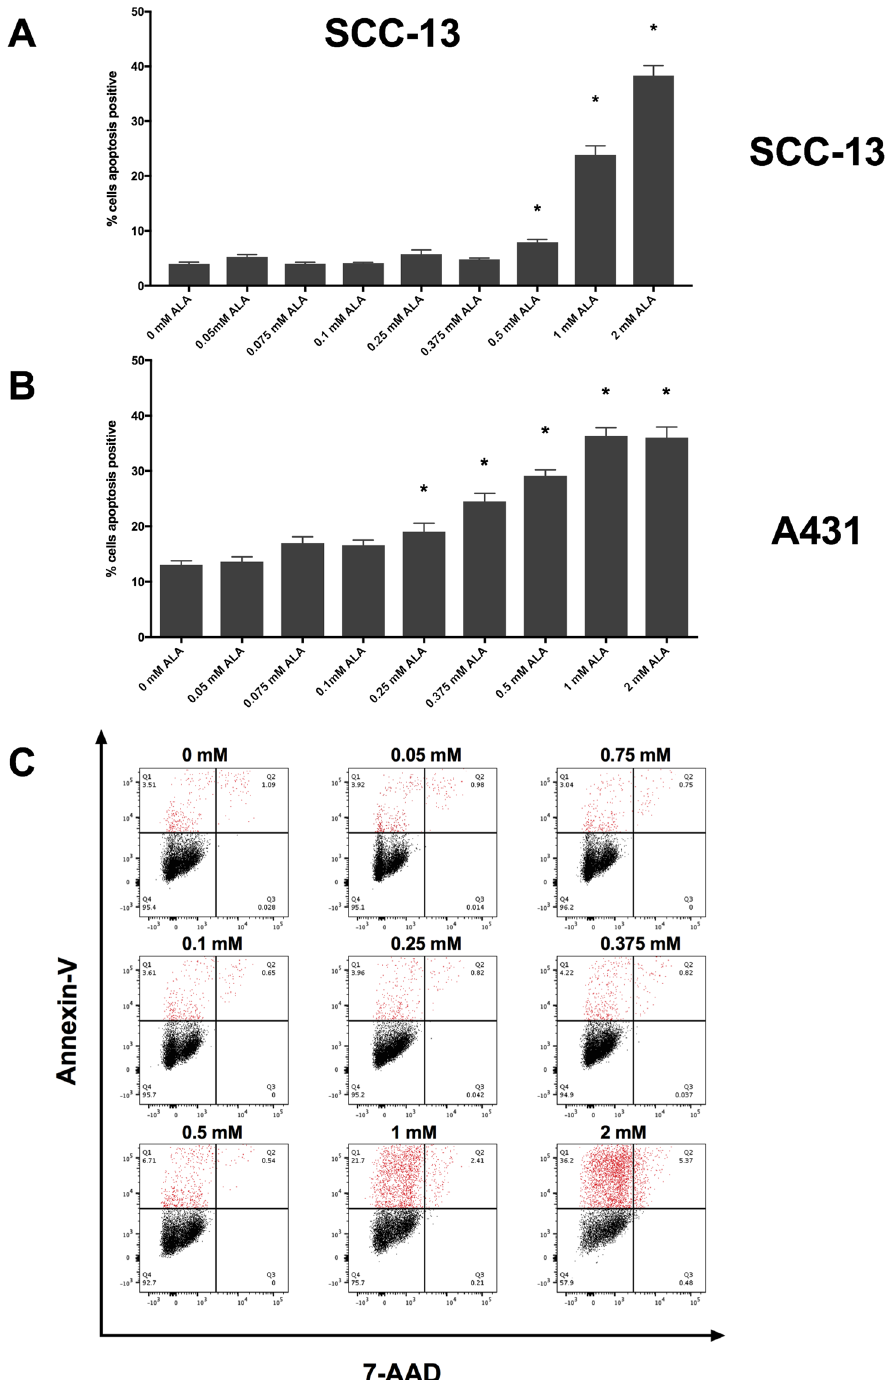
Figure 1. Thirty minutes incubation of 5-ALA induced a dose-dependent increase in apoptosis. ( A ) 5-ALA incubated at 36 °C for thirty minutes followed by 1000 seconds of blue light induced a dose-dependent increase in apoptosis in SCC-13 and ( B ) A431 cells. Bars represent average percent annexin-V positive cells in each treatment and control group. Error bars represent the mean ± standard error of the mean. * P < 0.05. ( C ) Representative annexin-V vs. 7-AAD flow cytometry plots for 0, 0.075, 0.1, 0.25, 0.375, 0.5, 1, and 2 mM 5-ALA incubated cells. Q1 – early apoptotic cells, Q2 – late apoptotic/necrotic cells, Q3 – necrotic cells, Q4 – viable cells. Apoptotic cells populations are highlighted in red. Experiments were performed in technical